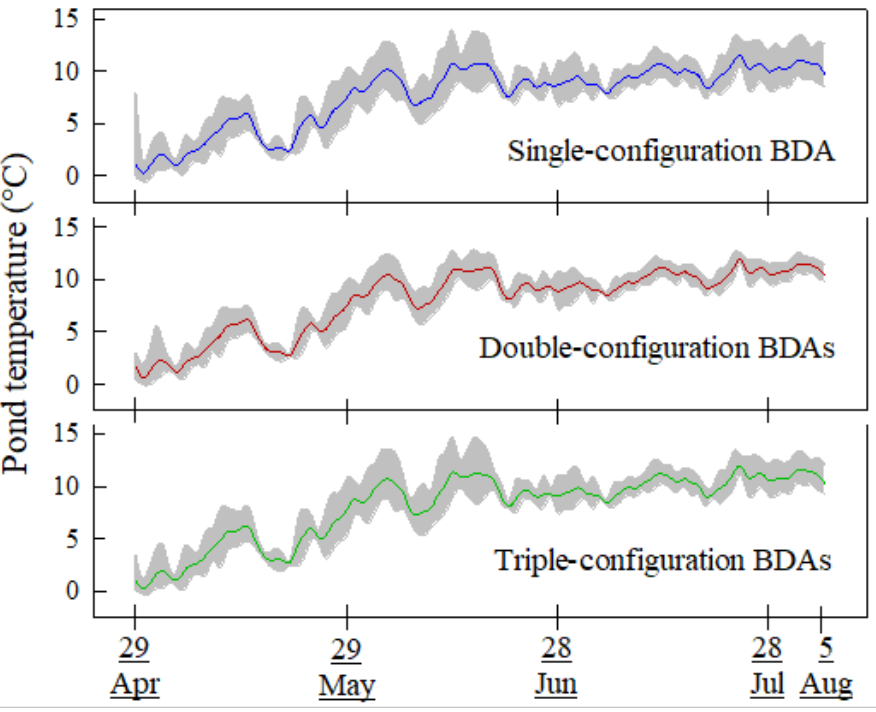
Figure 6. Daily pond temperatures for the three different BDA configurations over the 2019 post-BDA installation period.